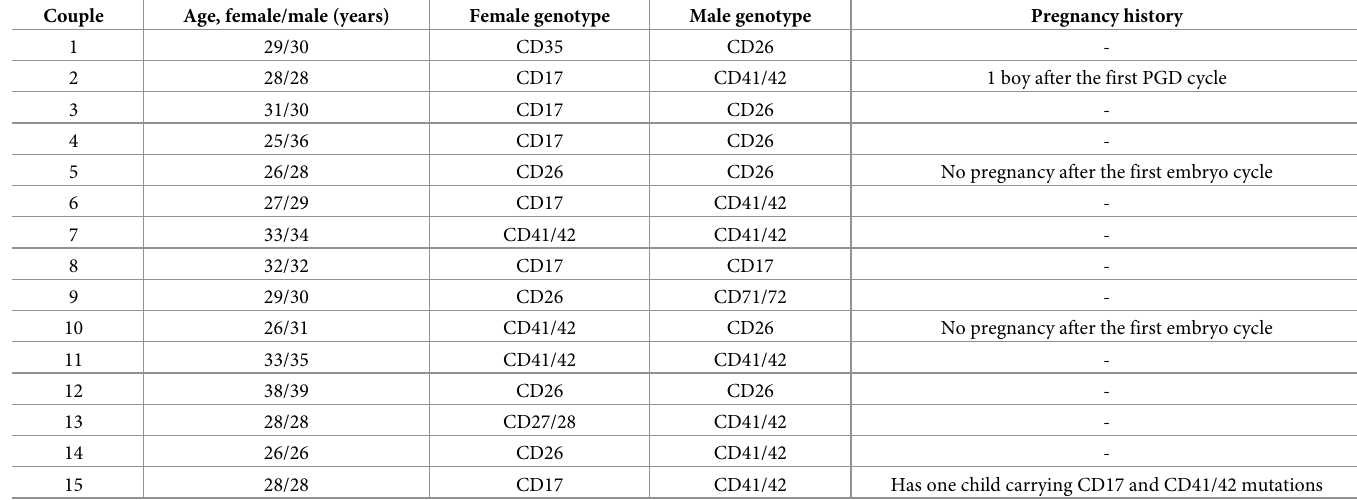
Table 2. Characteristics of